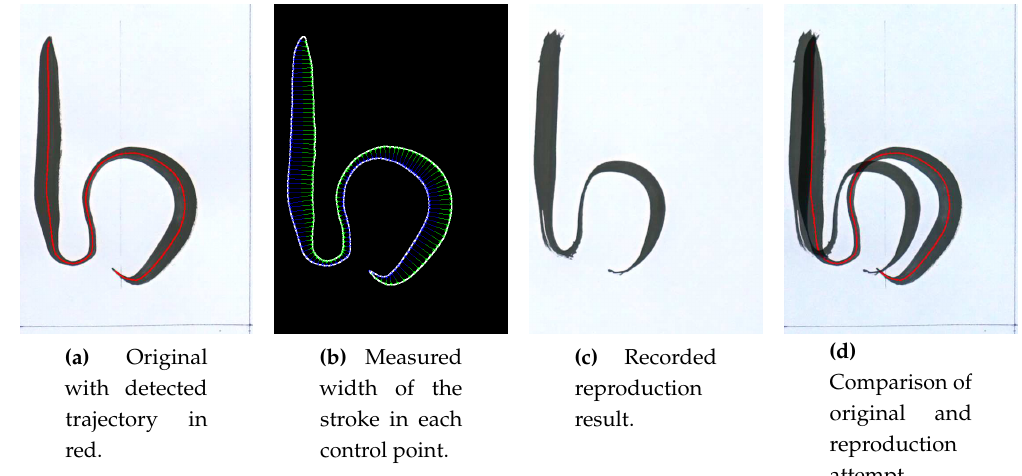
Figure 8. Reproduction of a stroke similar to the letter “b”.